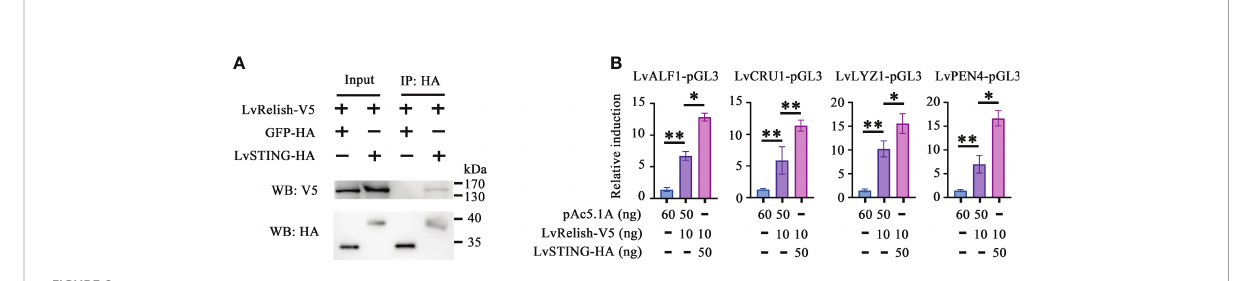
FIGURE 2 LvSTING triggered AMPs expression via interacting with LvRelish in vitro . (A) The Co-IP assays detecting the interaction between LvSTING and LvRelish. (B) The promoter activities of shrimp AMPs were induced by LvRelish with or without LvSTING in S2 cells. The data was analyzed statistically by student ’ s T test (* p < 0.05, ** p <